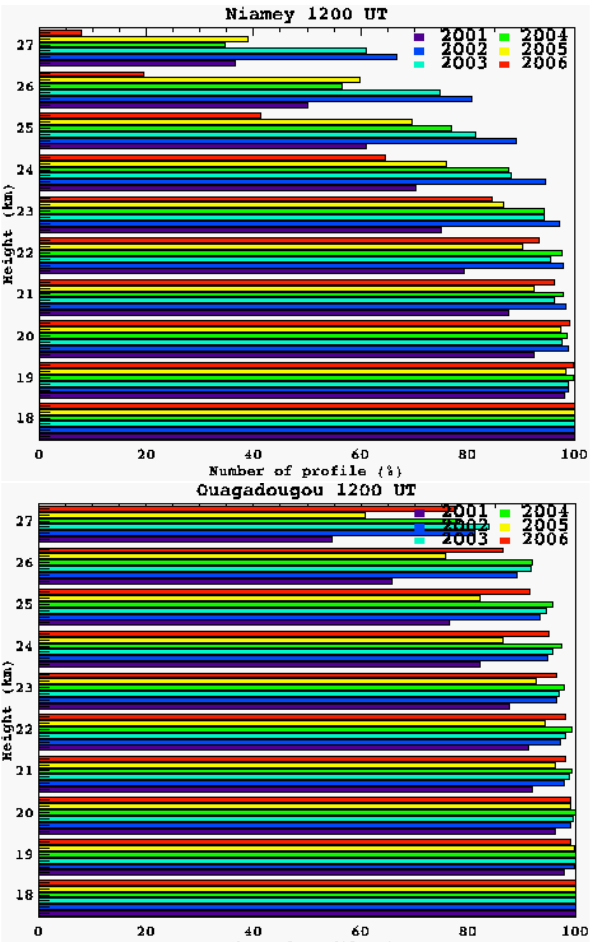
Fig. 3. Cumulative histogram of number of profiles (%) as a func- tion of height for (a) Niamey (12:00UT) and (b) Ouagadougou (12:00UT) from the altitude of 18km from 2001 to 2006. (2003) show weak sensitivity of GW analysis using polyno- mial fits with orders between 1 and 4. Thus perturbation pro- files are assumed to be mostly caused by